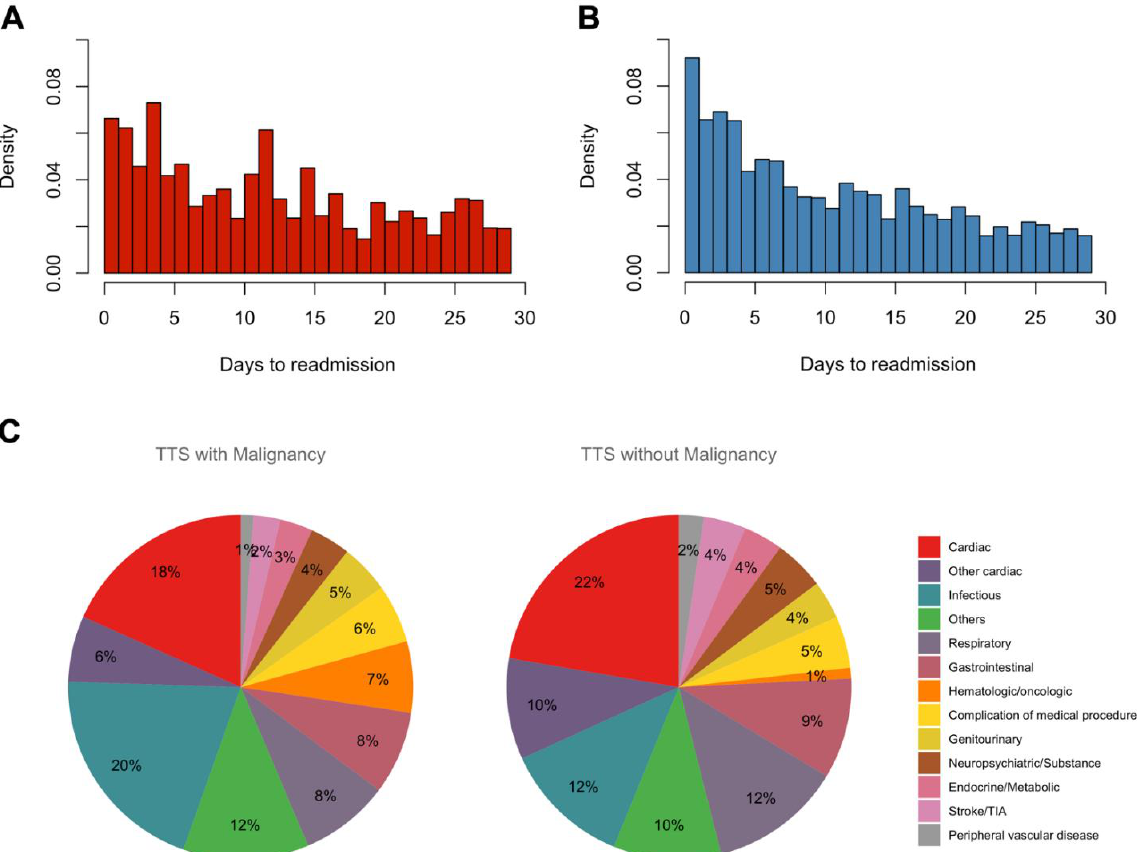
Figure 2. Timing and Causes of 30-day Readmissions for Takotsubo Syndrome with or without malignancy. ( A ) Time to readmission in TTS patients with malignancy. ( B ) Time to readmission in TTS patients without malignancy. ( C ) His- tograms representing different causes of 30-day readmissions in TTS patients with malignancy and without malignancy. Abbreviations: TTS, Takotsubo